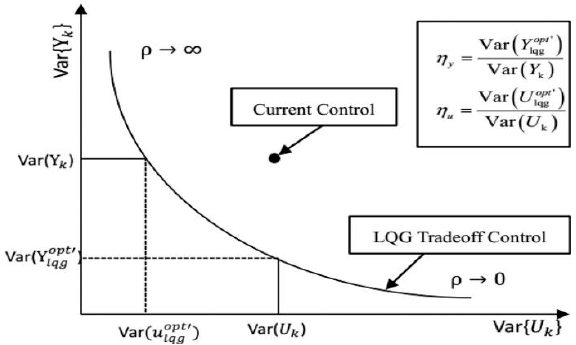
Figure 1. Linear quadratic Gaussian (LQG) performance tradeoff curve.